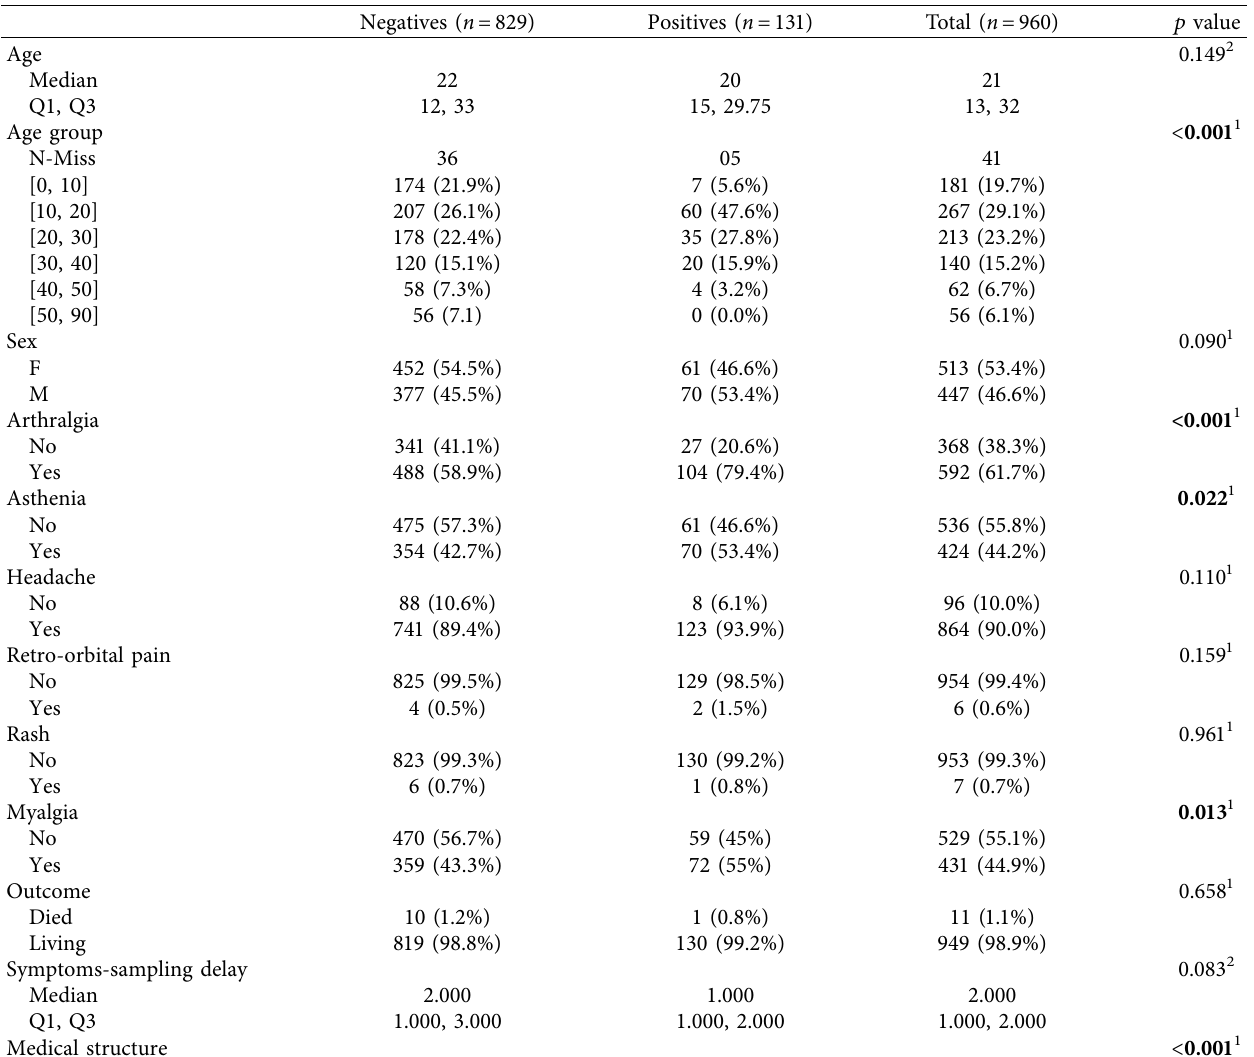
Figure 3: Distribution of suspected and confirmed DENV human cases according to epidemiological weeks in Louga City, 2017. Table 1: Epidemiologic and clinical characteristics of suspected and confirmed dengue fever cases, Louga, Senegal,